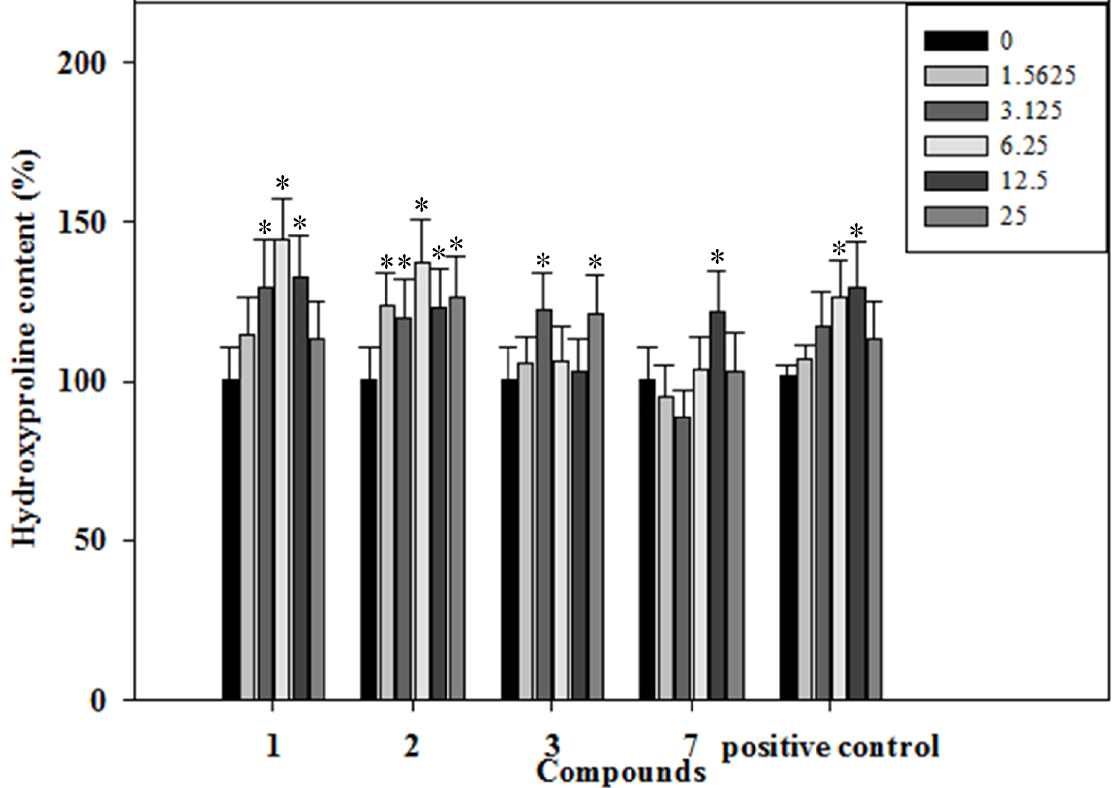
Note: * p ˂ 0.05 vs. negative